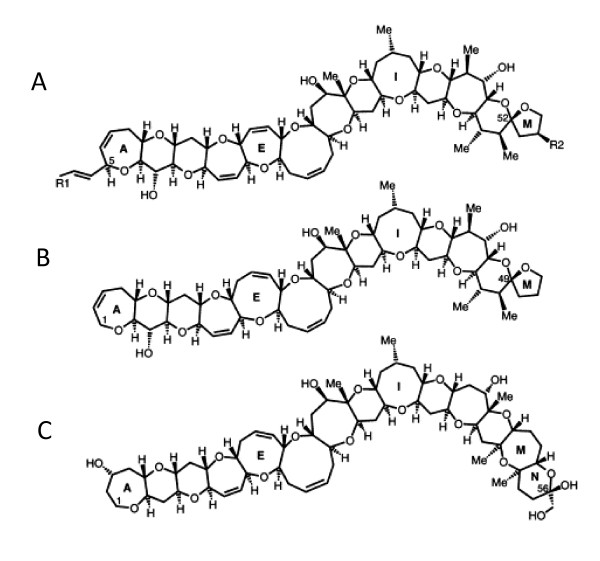
Backbones of Pacific and Caribbean ciguatoxins. A = P-CTX type 1, B = P-CTX type 2, C = C-CTX.